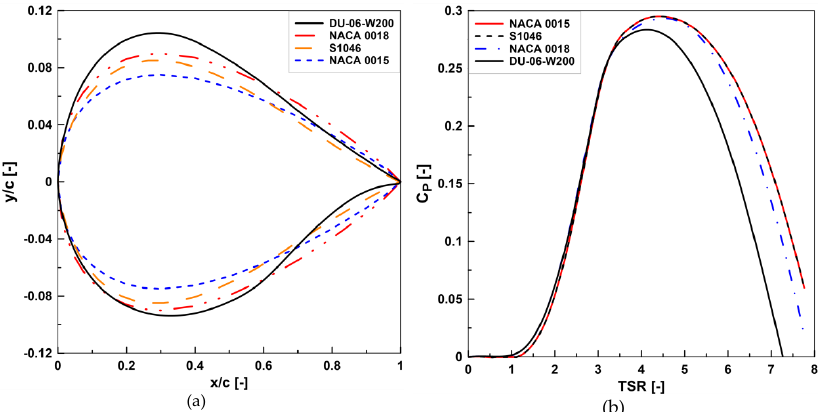
Figure 9. ( a ) Comparison between the four aerodynamic profiles in terms of coordinates ( b ) Performance curves for different aerodynamic profiles.